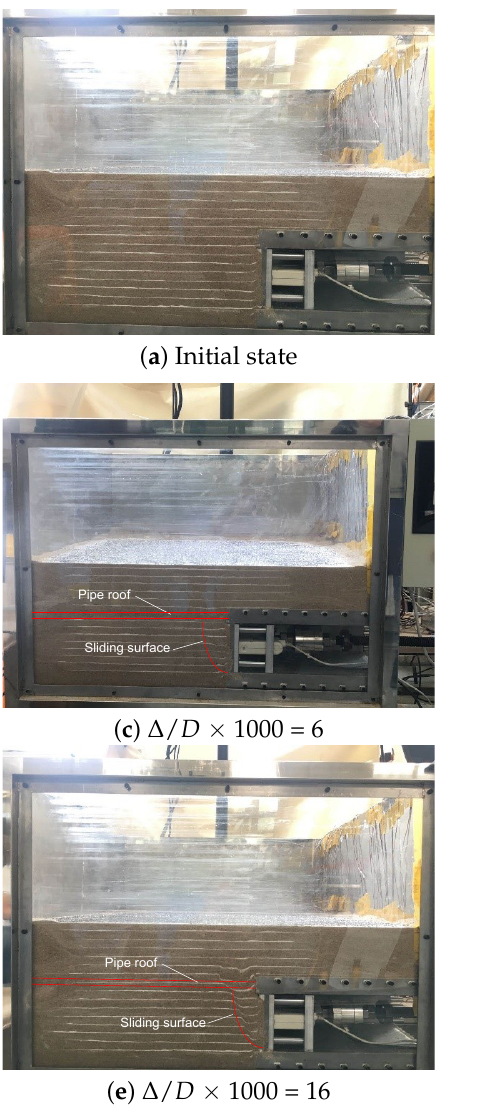
Figure 21. Instability process development during a test with the pipe roof ( C / D = 1, EI =